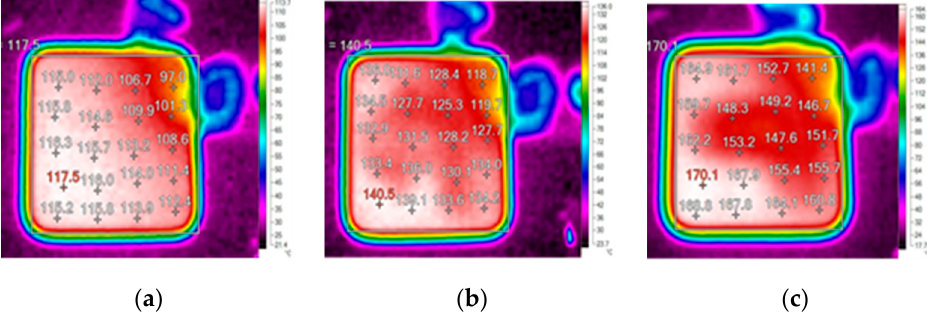
Figure 11. Surface temperature distribution of ZnO varistor under different pulse numbers. ( a ) Three pulses; ( b ) four pulses; ( c ) five pulses.